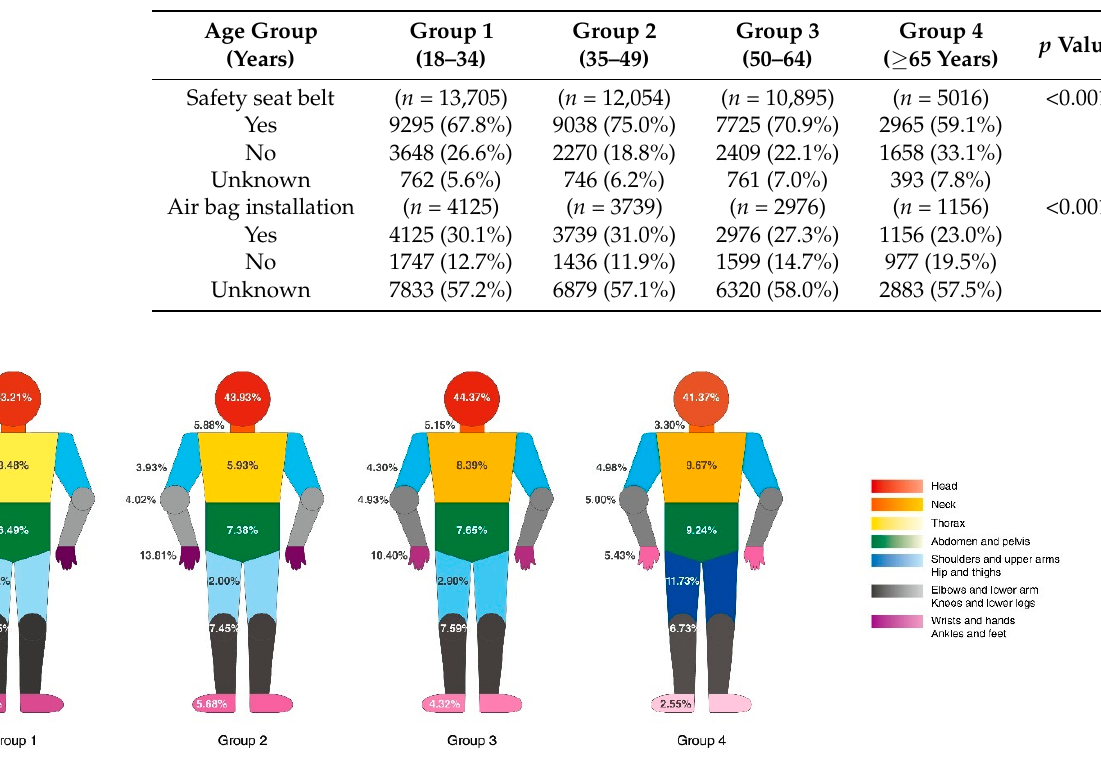
Table 3. Number of adults who wore a safety seat belt and cars in which airbags were installed at the time of the transport injury that occurred in a car, by age group, in 2016–2017.